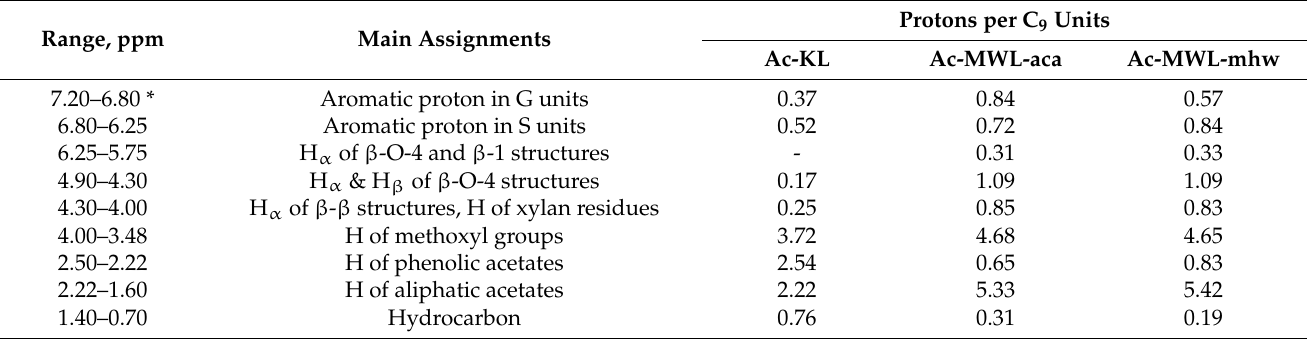
Table 6. 1 H NMR assignments and distribution of protons per C 9 structural unit of acetylated lignins. Range, ppm